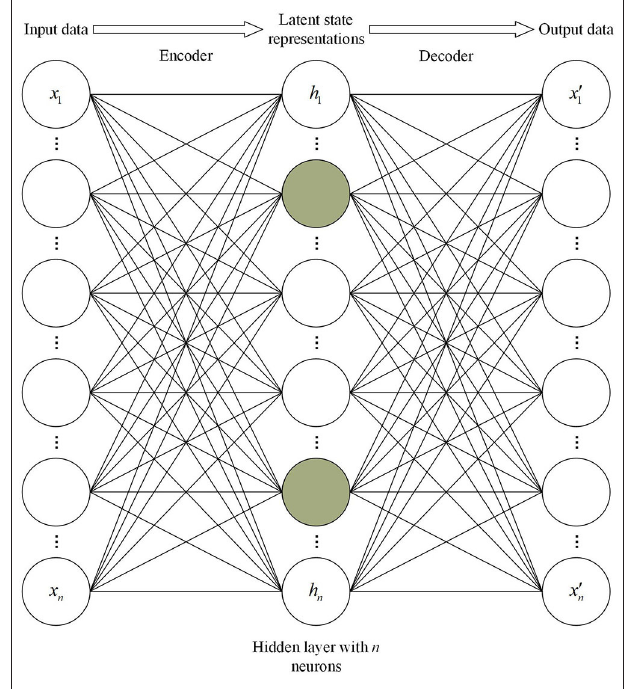
FIGURE 3 | Architecture of the sparse